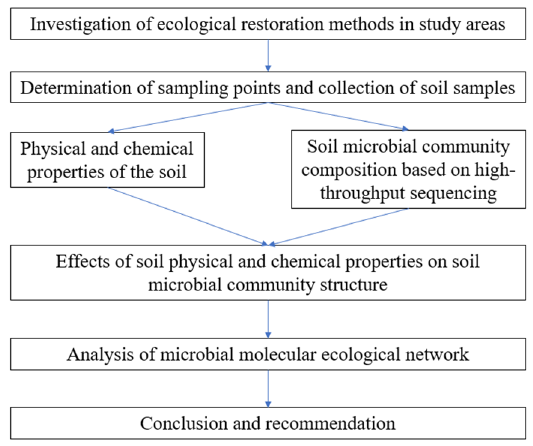
Figure 1. Logic diagram of the present research.